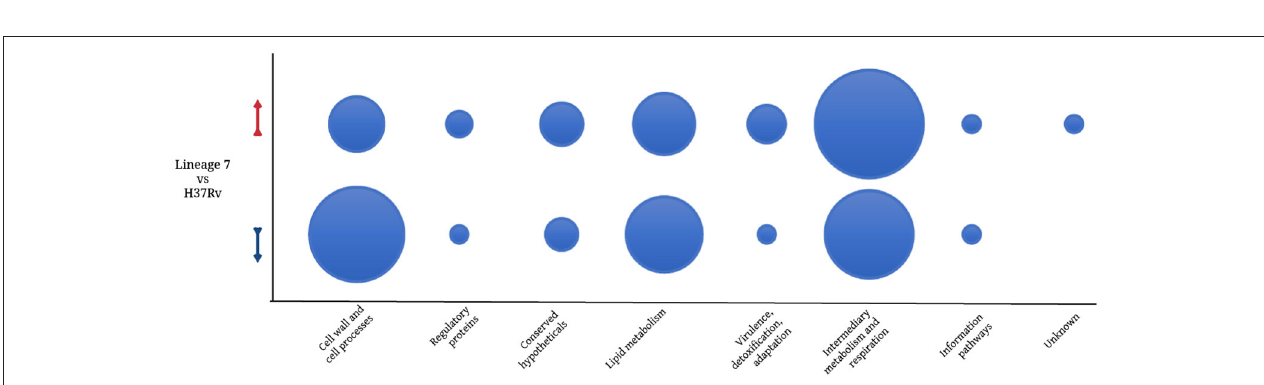
FIGURE 4 | Quantitative proteomics analysis reveals distinct pattern of M. tuberculosis differentially abundant proteins that are involved in several important pathways. (A) Unsupervised hierarchical clustering representing the T -test significant proteins ( n = 125). Color code indicates the normalized median abundance of the proteins belonging to the category (red more abundant; green less abundant). (B–D) Representative clusters of significantly enriched KEGG pathways.